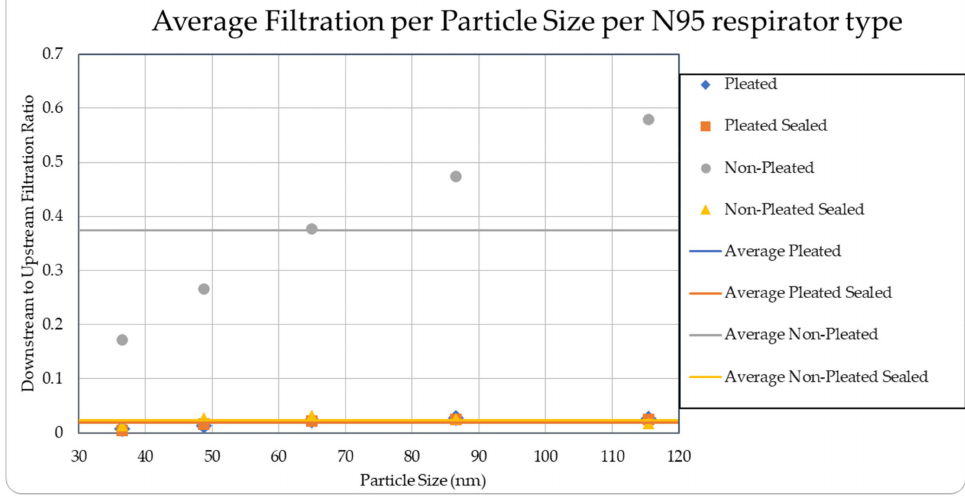
Figure 10. Average filtration ratios per particle size at the Observer Position Stick